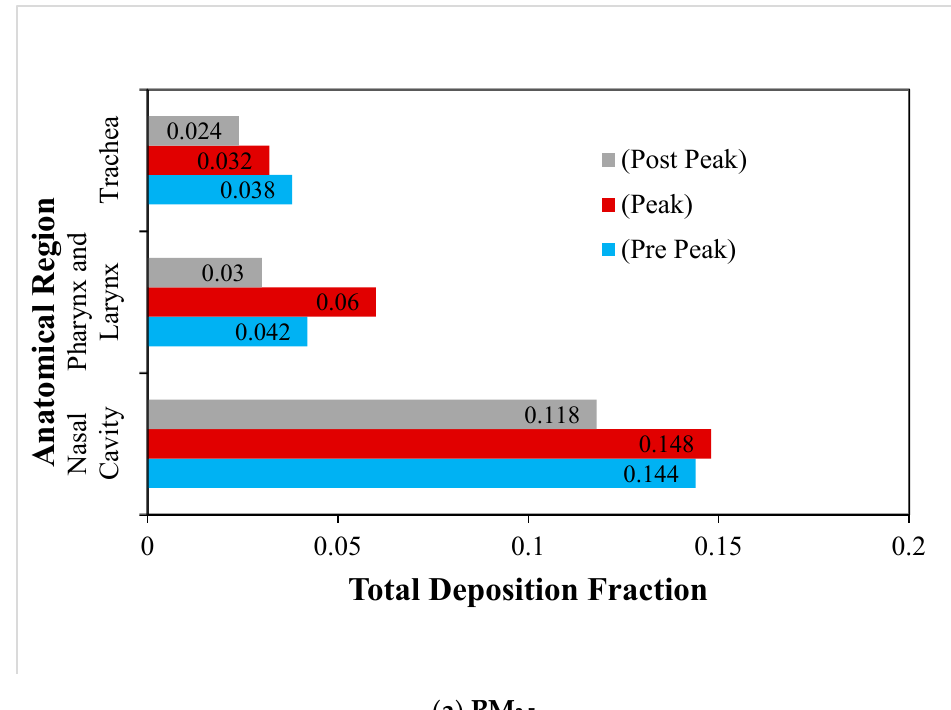
Figure 6. Regional deposition fraction (RDF) of RSPM in the upper airways at normal inspiration.